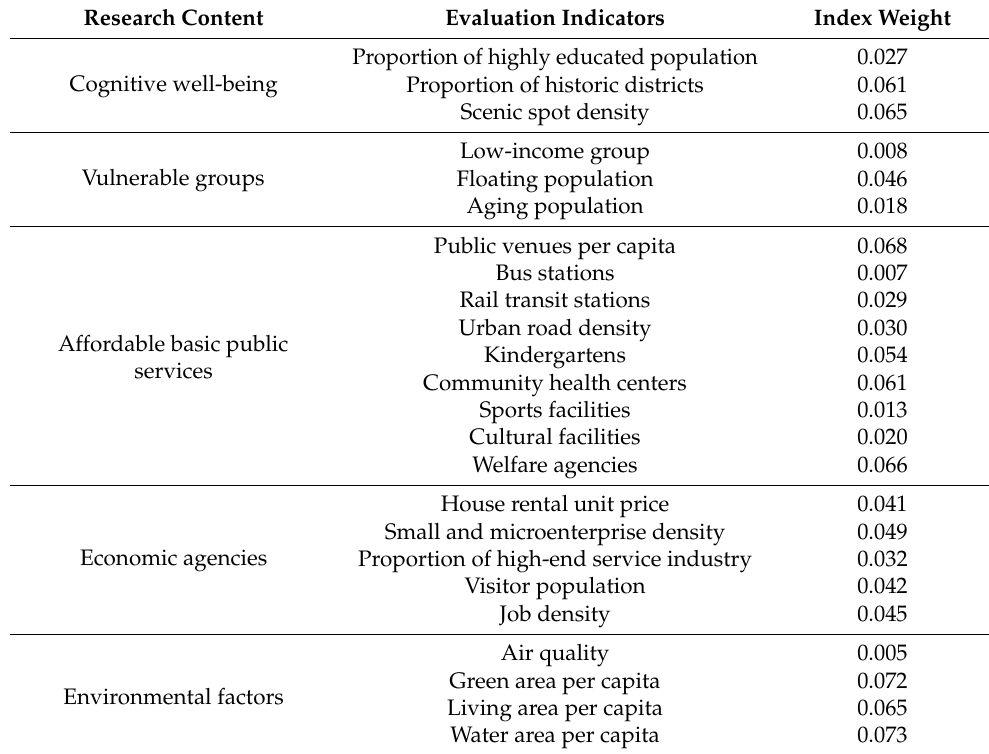
Table 2. Urban renewal spatially inclusive development indicator